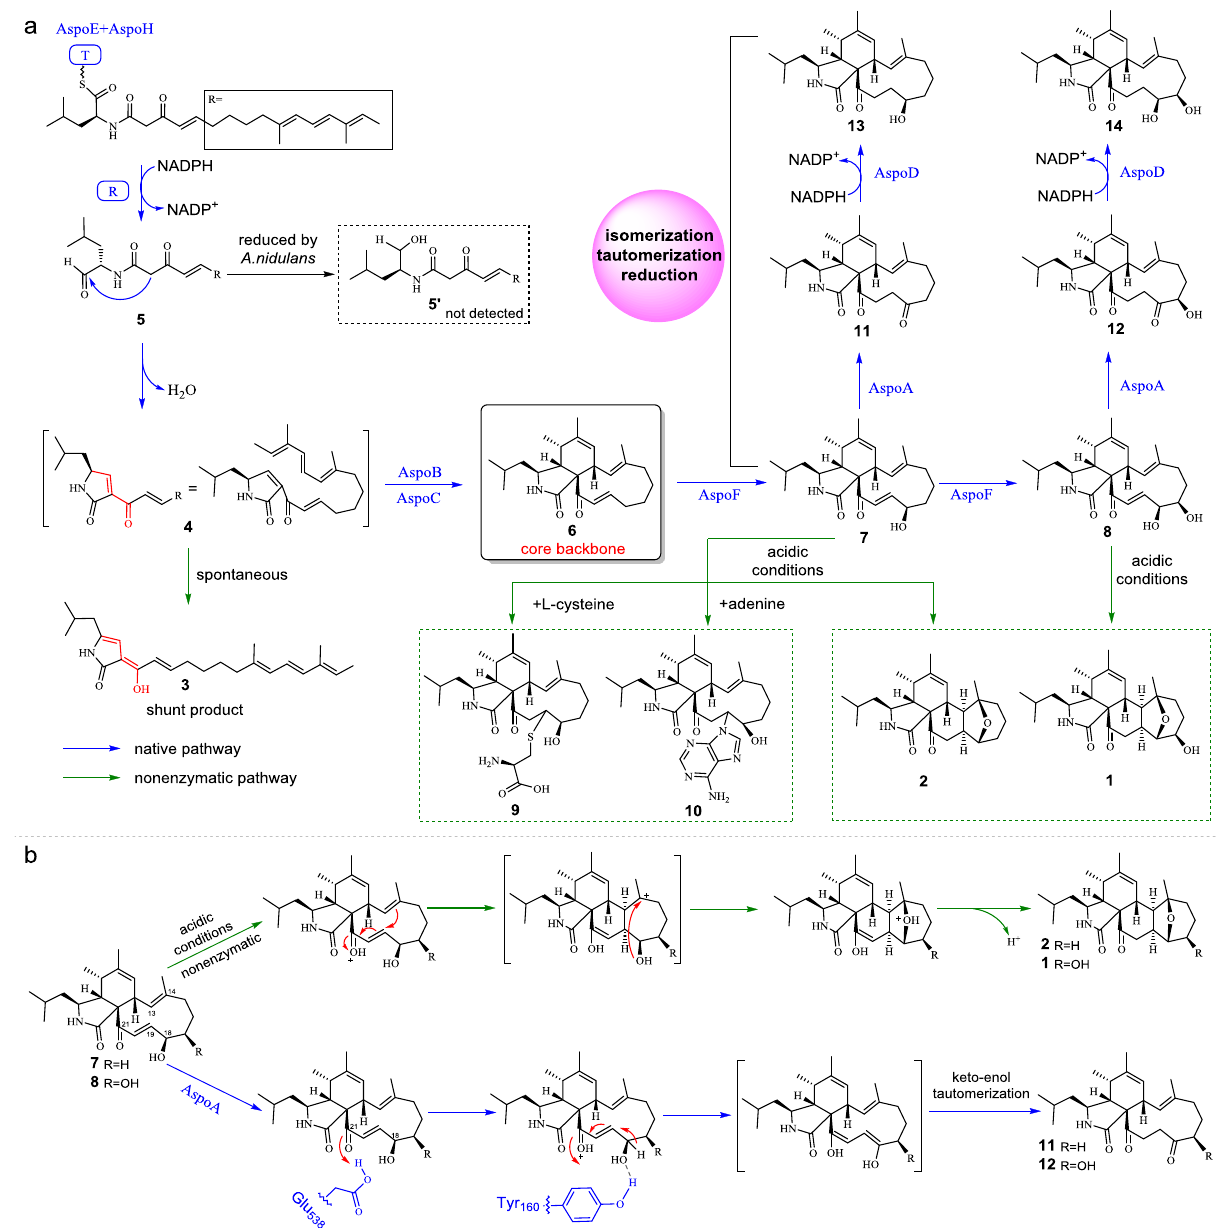
Fig. 3 The proposed biosynthetic pathway of the aspochalasin family of compounds. a The pathway identi fi ed in this work shows the enzymatic (for the monocyclic) and nonenzymatic (for the mero- and polycyclic) chemical conversions, where 6 is the core backbone and AspoA acts as a pathway switch. b The proposed mechanism of conversion of 7 or 8 to 2 or 1 via protonation of the C 21 carbonyl group under acidic conditions and the proposed mechanism of AspoA-catalysed isomerization of 7 or 8 to 11 or 12 by Glu 538 -mediated protonation of the C 21 carbonyl